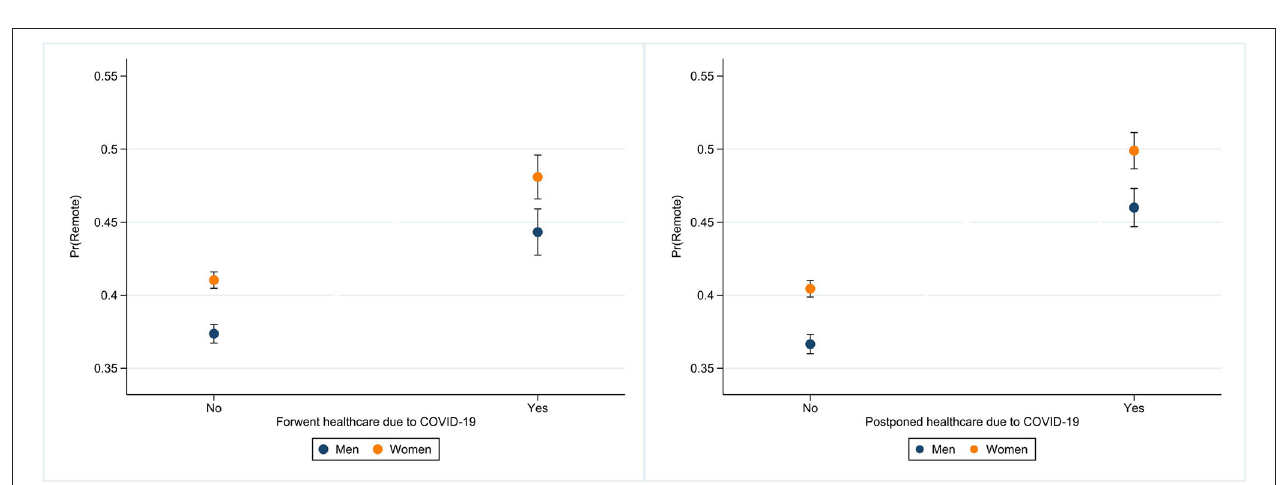
FIGURE 1 | The percentage of respondents aged 50 and over who had remote medical consultations since the outbreak by country (second SCS June–August 2021). Note: Black line represents the sample average–otherwise weighted data with 95% CI.